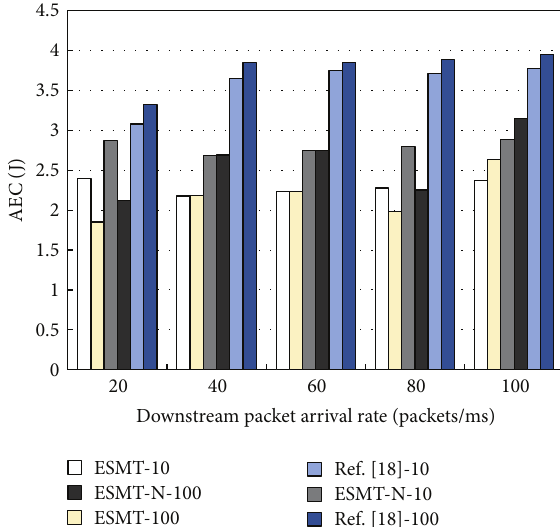
Figure 14: Comparison of AEC under the two scenarios.